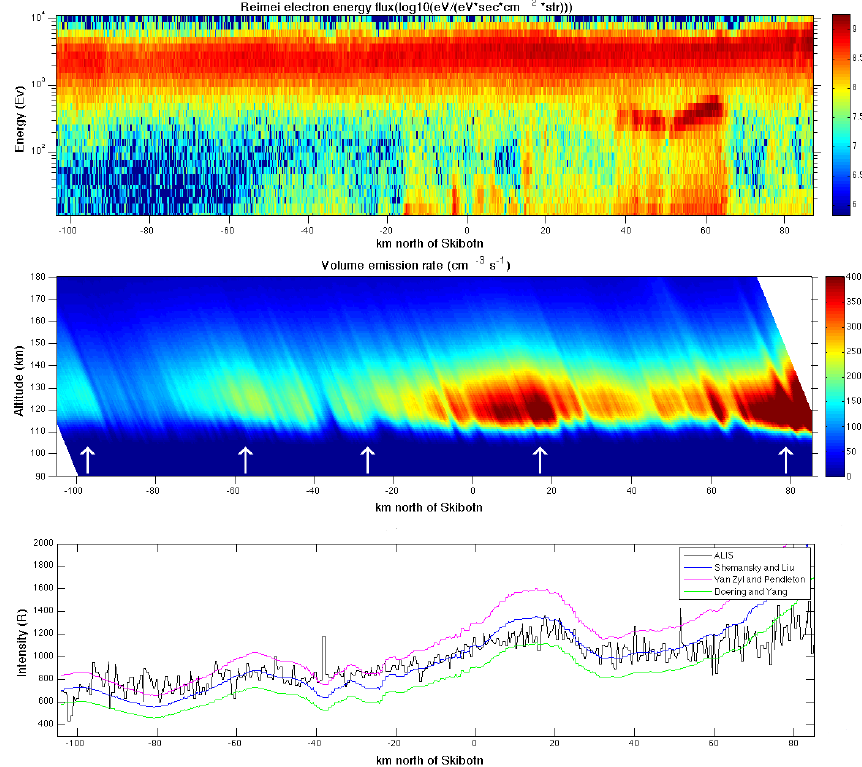
Figure 6. Upper panel: Electron energy spectrum along the track of the Reimei satellite. Middle panel: Volume emission rate as a function of altitude along the satellite track. The white arrows correspond to the arcs marked in Fig. 5. Lower panel: The black line shows the intensity of the 427.8nm emission measured by ALIS. The three colored lines show the calculated intensity using cross sections from Van Zyl and Pendleton (1995), Shemansky and Liu (2005) and Doering and Yang